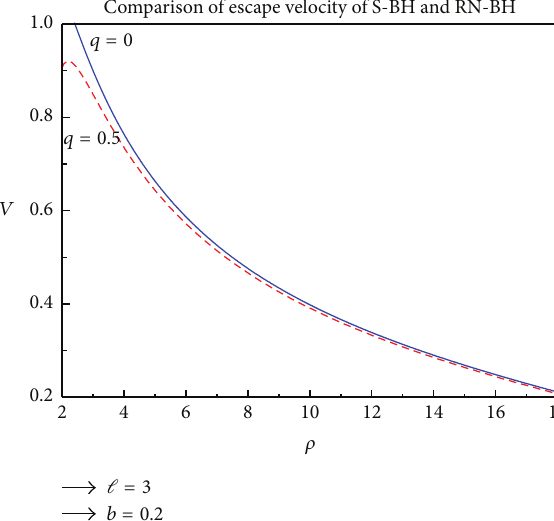
Figure 10: Escape velocity as function of 𝜌 for both Schwarzschild black hole and RN-BH.